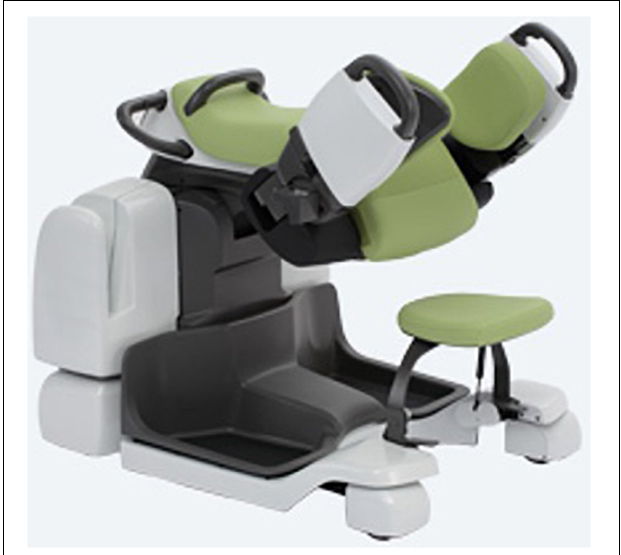
FIGURE 1 | Care Assist Robot (Source: Future of Occupation, 2015).